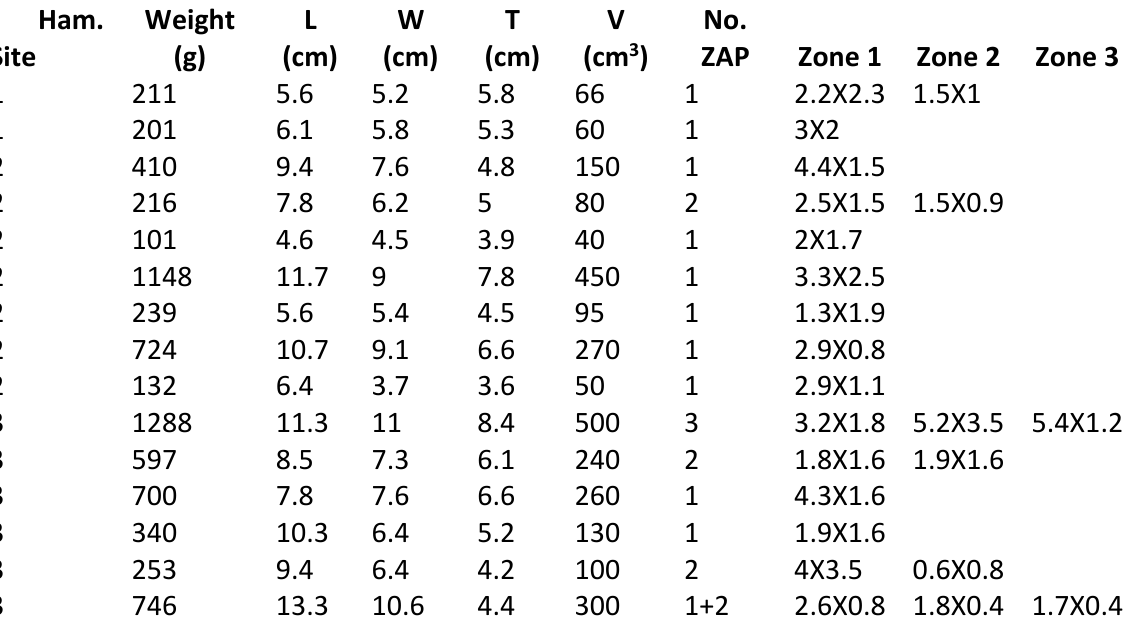
Table 4. Metric analysis of archaeological flint hammerstones used in this study.1 Calabazas site; 2 CPD30 site; 3 P32 site.